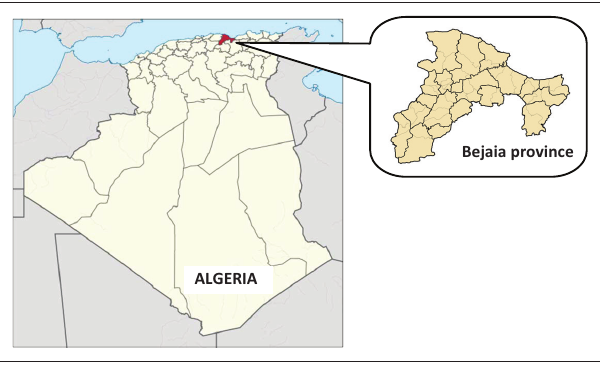
TABLE 1: Annual rainfall and temperature data of the Bejaia area (Algeria) during 2016. Month Temperature (°C) Rainfall Mean